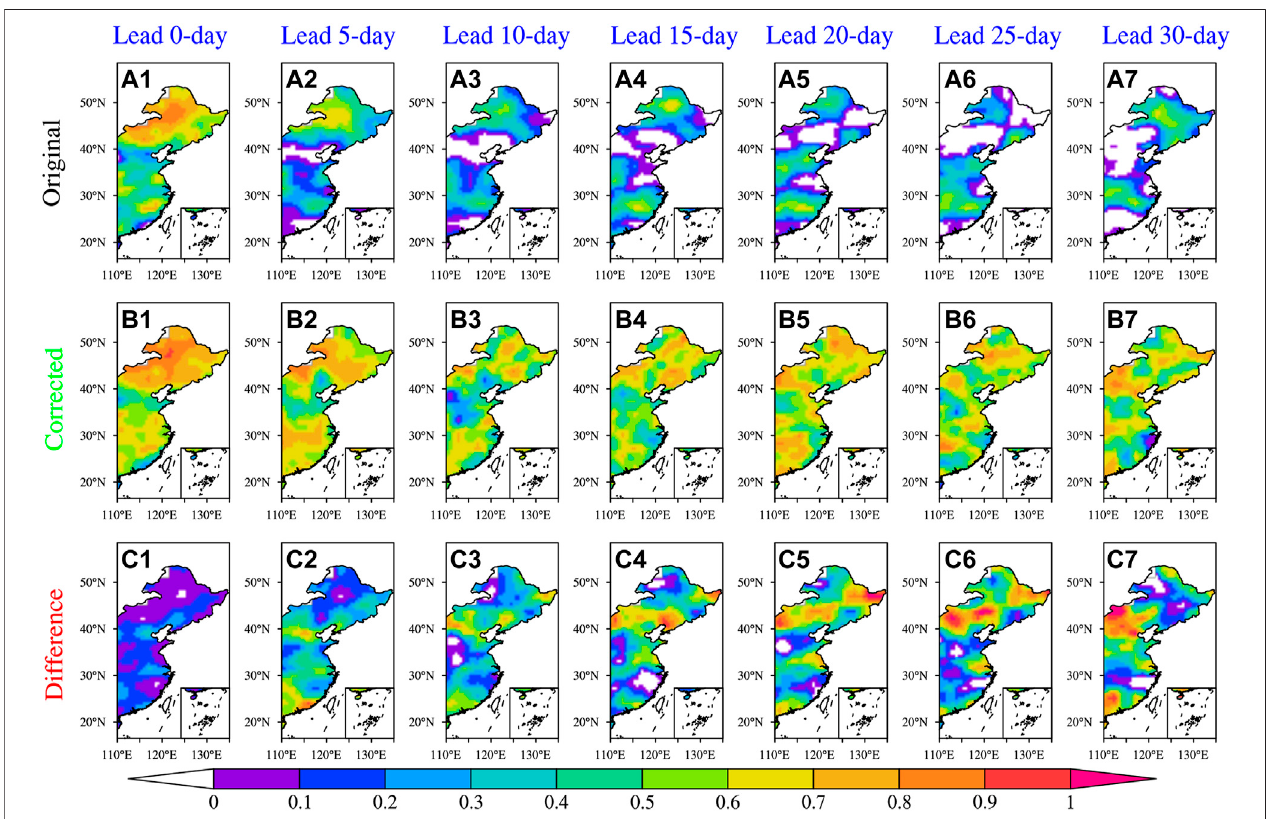
FIGURE 6 | Distributions of the 20-year average TCC of the original predictions (A1 – A7) , the bias corrected predictions (B1 – B7) with observations and their differences (bias corrected predictions — original predictions) (C1 – C7) for the summer precipitation with different forecast lead time in Eastern China during 1994 – 2013.